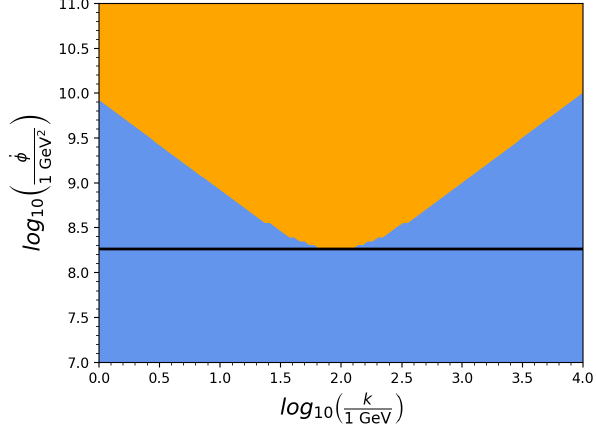
Figure 1 . The plot shows where the matrices in eq. (2.6) contain no negative eigenvalue (blue region) or at least one negative eigenvalue (orange region) in terms of the energy ˙ φ and momentum k . This implies that the orange region is where the mixing particle production condition is satisfied. The black line indicates the minimum energy ˙ φ that the mixing particle production condition could be satisfied at corresponding momentum k , i.e., eq. (2.8). Noted that the other parameters are